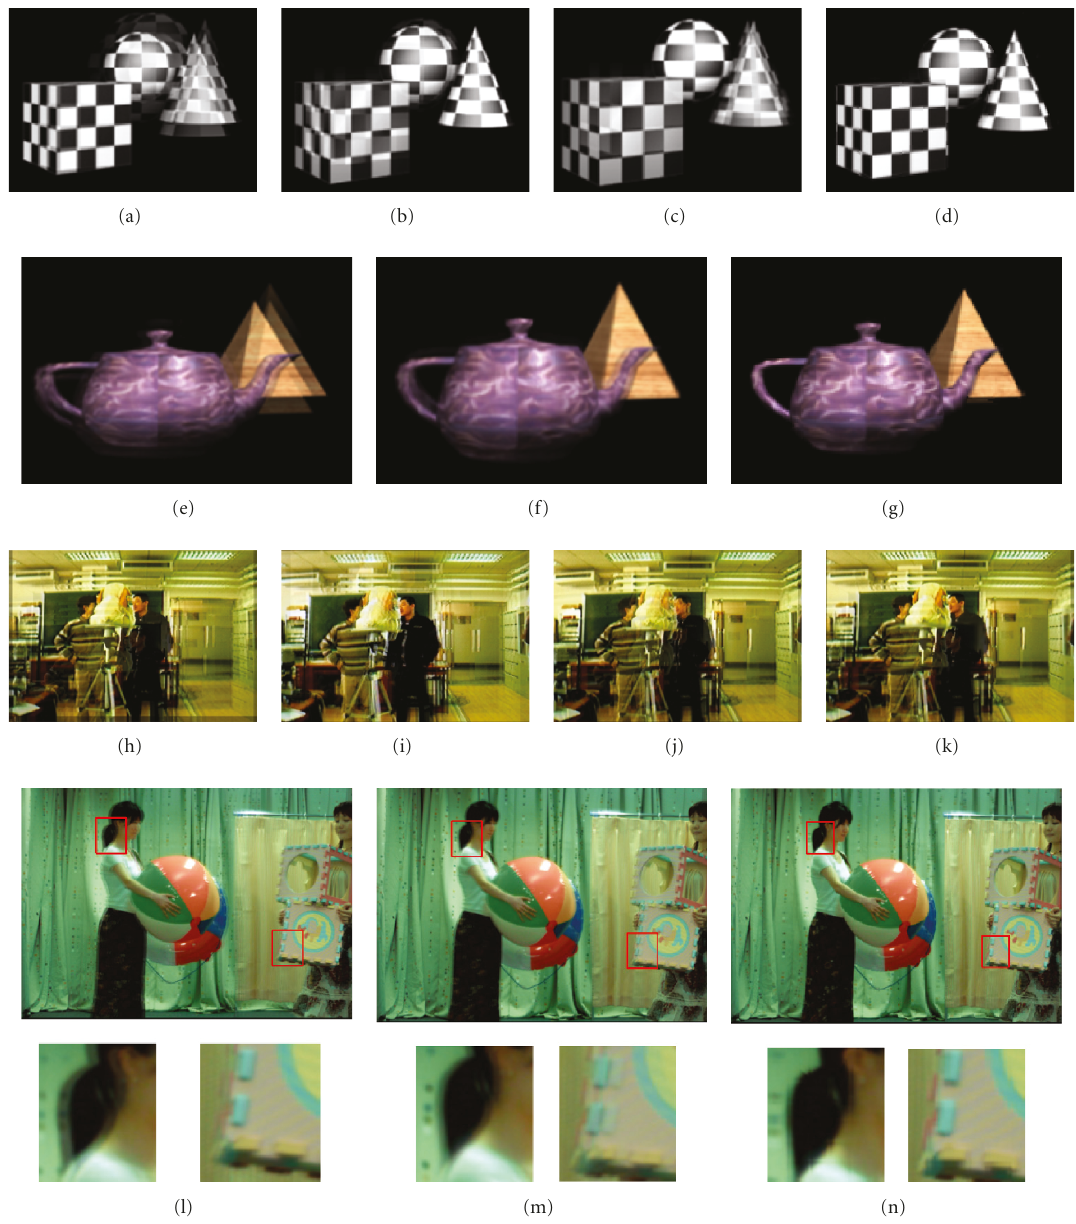
Figure 18: (a)–(d) Synthetic scene of objects with grid textures. (e)–(g) Synthetic teapot scene. (h)–(k) Real-world scene: “Room.” (l)–(m) Real-world scene: “Akko and Kayo.” In each of the four scenes, from left to right, there are: the result rendered with const depth at nearer objects; the result rendered with const depth at farther objects; the all-clear images are in the last column.